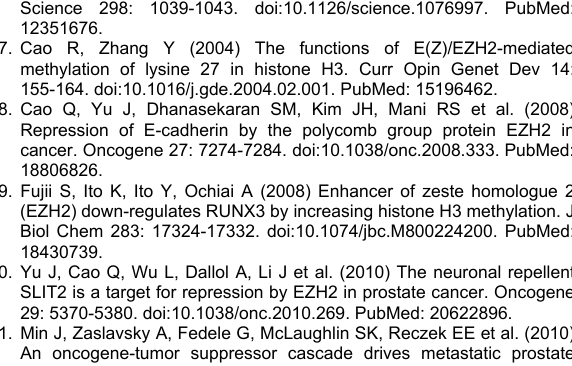
Figure S3. Publicly available ChIP-sequencing and ChIP-on- chip database was analyzed to provide clues of DLC1 chromatin status in human embryonic stem cell. DLC1 locus was found to be marked by H3K27me3 (Zhao et al., 2007) and H3K4me3 (Pan et al., 2007) in independent studies. Furthermore, DLC1 promoter was also found to be bound by SUZ12 (Lee et al., 2006), which is a core component of the Polycomb Repressive Complex